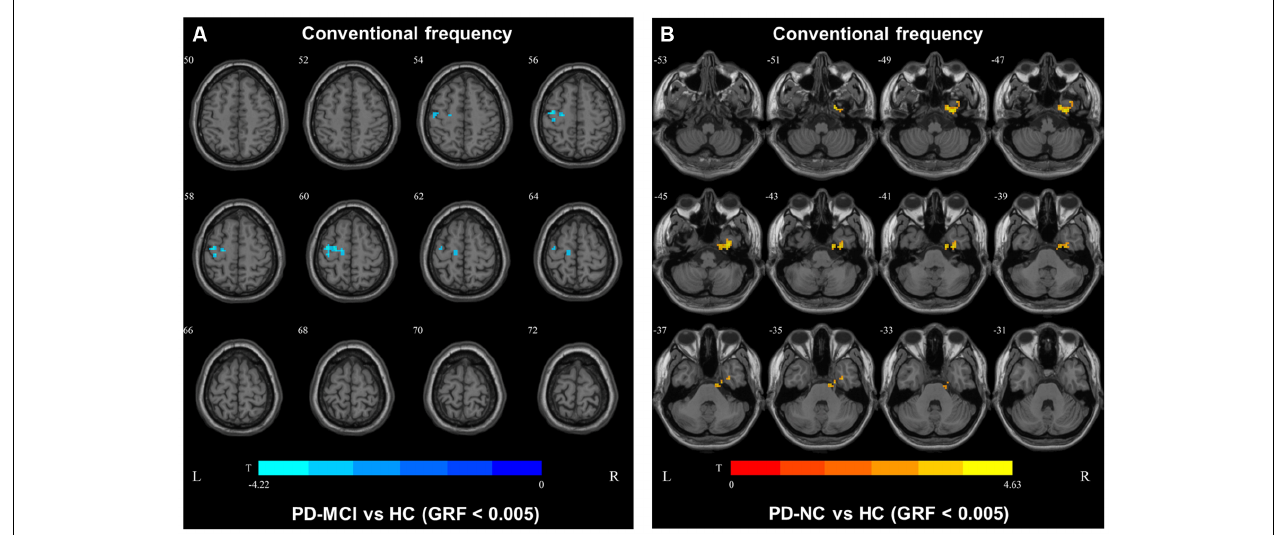
FIGURE 1 | Degree centrality (DC) map differences among the groups in conventional frequency band. The DC results were compared by two sample t -tests (GRF corrected, voxel p < 0.005, cluster p < 0.05). The color bar on the bottom indicates the statistical t value. The warm (cold) color indicates a significantly increased (decreased) distant DC in the comparison. Additional details regarding these regions with difference are shown in Table 2 . (A) Decreased DC in PD-MCI patients between PD-MCI and HC. (B) Increased DC in PD-NC patients between PD-NC and HC.